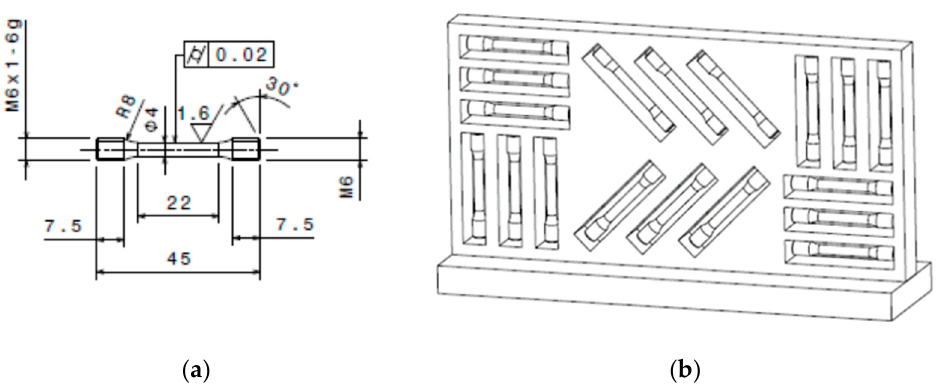
Figure 5. Specimens for tensile tests extracted from Ti6Al-4V PAW-WAAM walls: ( a ) Specimen drawing for evaluating the wall material following ISO 6892-1 standards; ( b ) Specimens in horizontal and vertical direction for evaluating the added material.